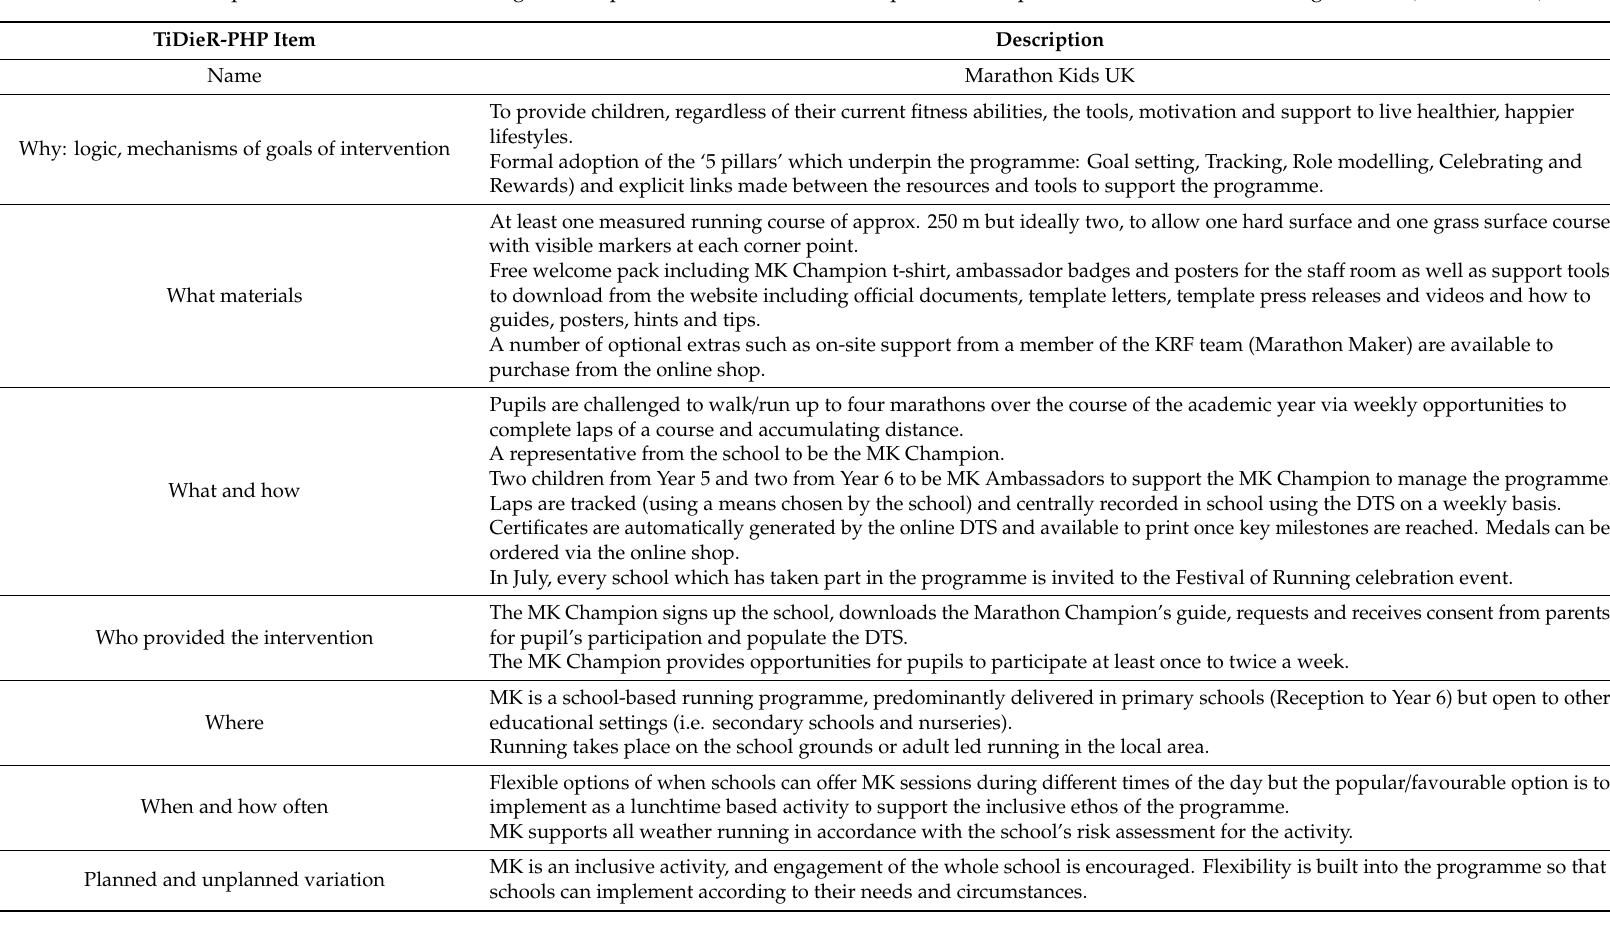
Table A1. Description of Marathon Kids using the Template for Intervention Description and Replication in Public Health Programmes